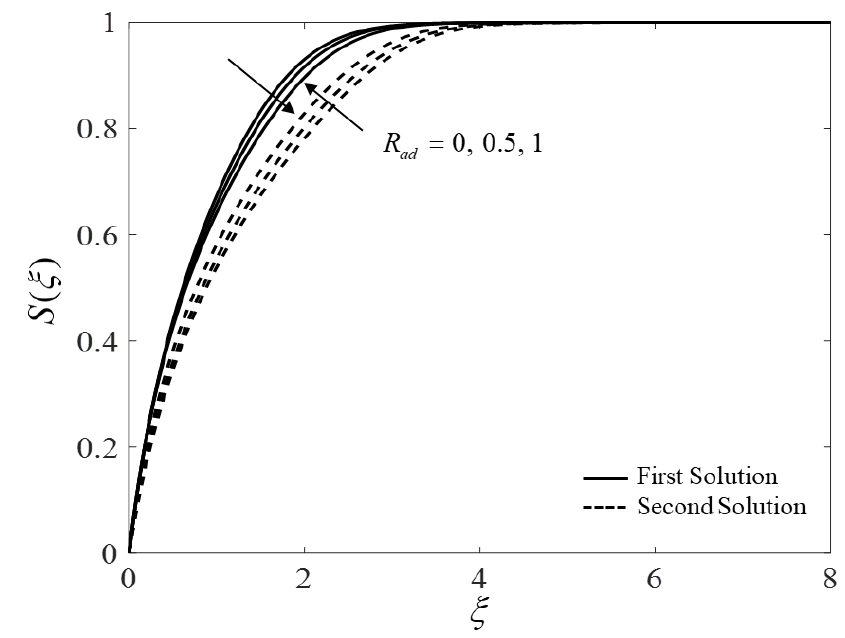
Figure 14. Concentration distribution S ( ξ ) for different values of R ad